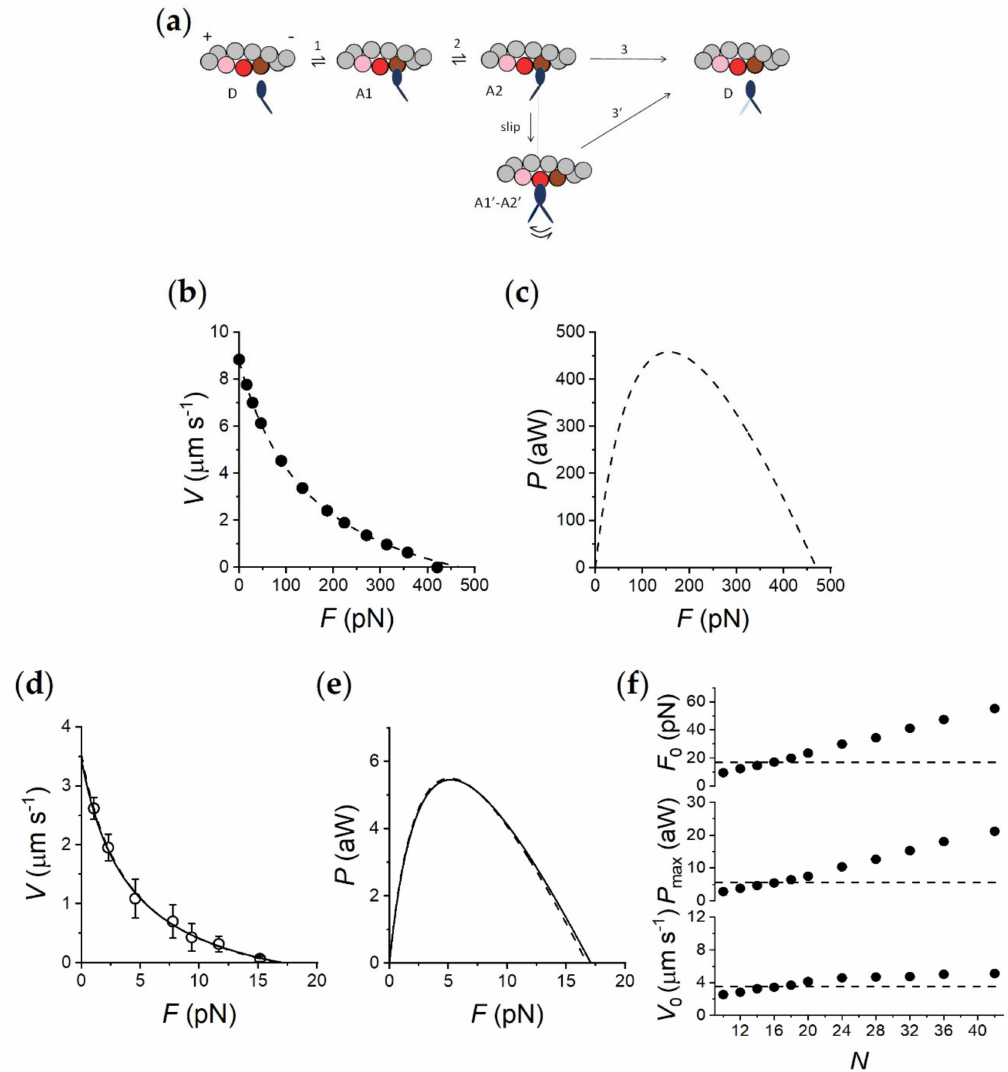
Figure 3. Model simulation. ( a ) Kinetic scheme from [10], with three states of the myosin motor (blue): D, detached; A1 and A2, attached to an actin monomer (brown). During shortening, the motor attached in the A2 state can slip to the next actin monomer farther from the center of the sarcomere (red) within the same ATPase cycle. The probability of a second slipping to the pink monomer is limited to 1 / 10 of that of the first slip. ( b ) Simulation of the F - V relation of fast mammalian muscle (adapted from supplementary figure 6f in [10]). The experimental F - V relation (filled circles) is calculated for the half-sarcomere at full overlap (294 motors available) from the data of fast mammalian muscle at room temperature [31,32]. The dashed line is Hill’s hyperbolic equation fitted to the results of the model simulation with a series compliance similar to that in situ (0.01 nm pN -1 ). ( c ) P - F relation calculated from Hill’s fit in b (adapted from supplementary figure 6g in [10]). ( d ) Experimental F - V relation obtained by pooling data in the absence and the presence of Ca 2 + from Figure 2 (open circles) and fitted by Hill’s hyperbolic equation (dashed line), and its simulation calculated for a number of available heads N = 16 (continuous line). ( e ) Corresponding P - F relations. ( f ) Dependence on N of the three parameters featuring the machine performance, as indicated in the ordinate of each plot. The dashed lines indicate the respective experimental